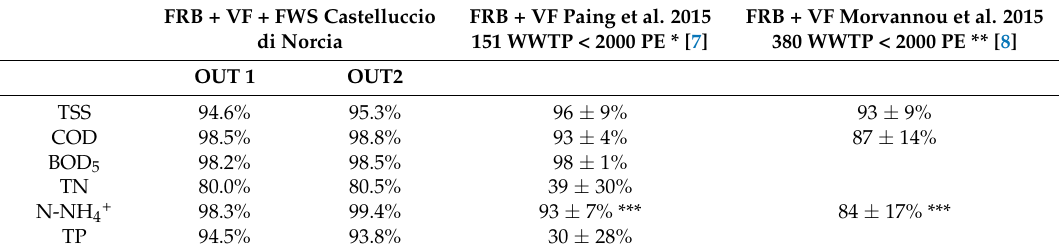
Table 6. Comparison of average removal efficiencies of the FRB WWTP of Castelluccio di Norcia with the data from the ample French dataset